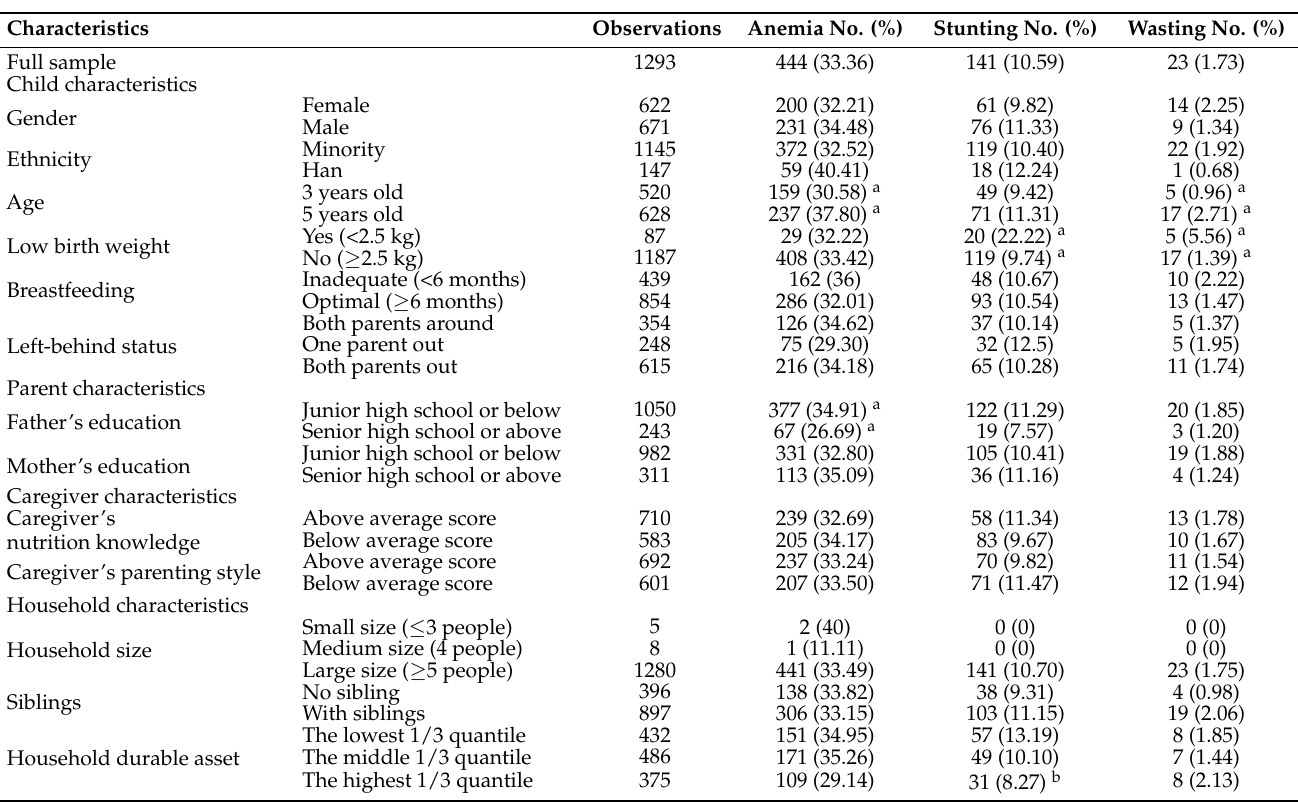
Table 1. Descriptive statistics and prevalence of child undernutrition by